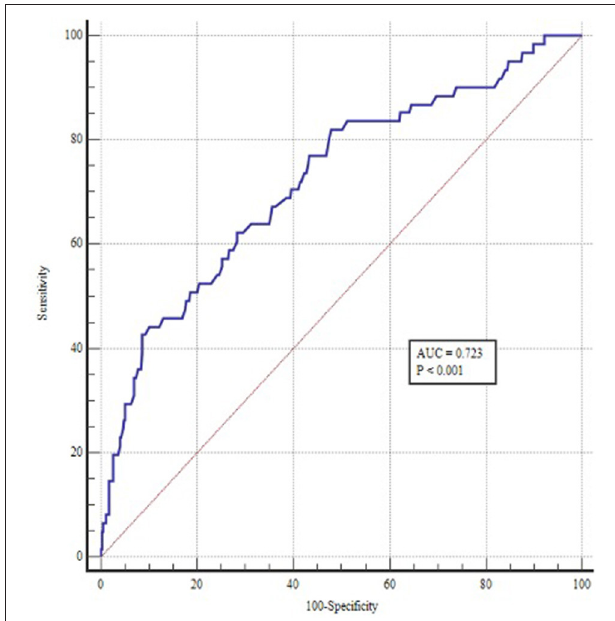
FIGURE 1 | ROC curve of TyG index for predicting POAF in patients undergoing septal myectomy. The optimal cut-off point was 7.60 with sensitivity and specificity of 44.3 and 90.5% (area under the curve 0.723, 95% CI: 0.650 to 0.796, P < 0.001).